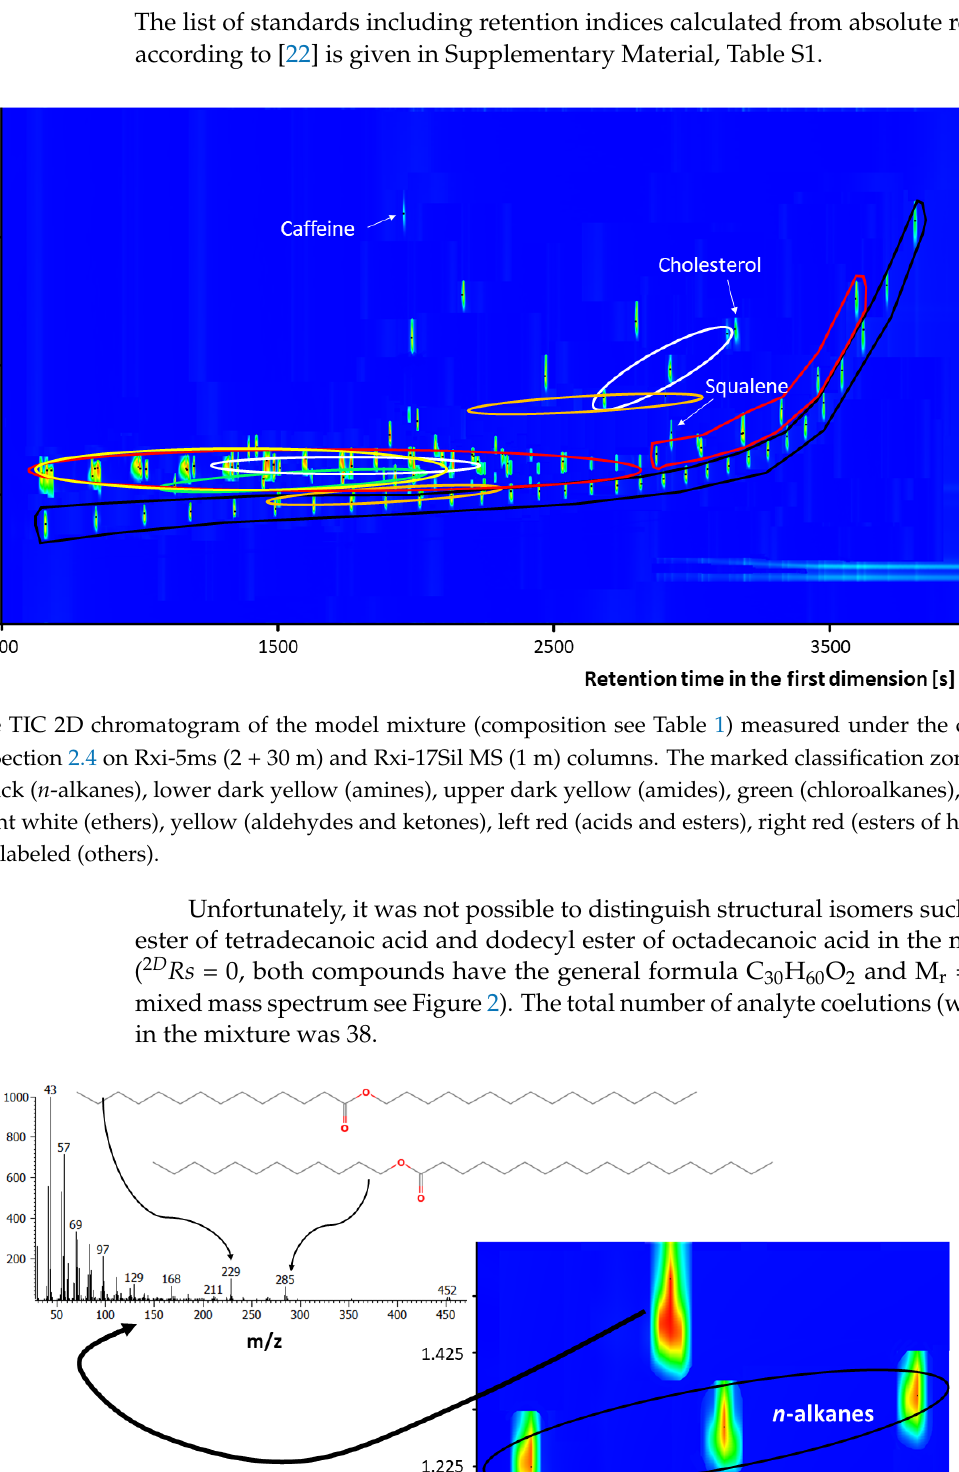
Figure 3. The TIC 2D chromatogram of a real scent sample measured under the conditions described in Section 2.4 on Rxi- 5ms (2 + 30 m) and Rxi-17Sil MS (1 m) columns. 3.2. Classic Arrangement: Non-Polar Rxi-5MS (2 + 30 m) + Medium Polar Rtx-200MS (1 m) In another tested arrangement, the secondary column was replaced with the Rtx- 200MS column with a (trifluoropropyl)-methylpolysiloxane phase, which, like Rxi-17Sil